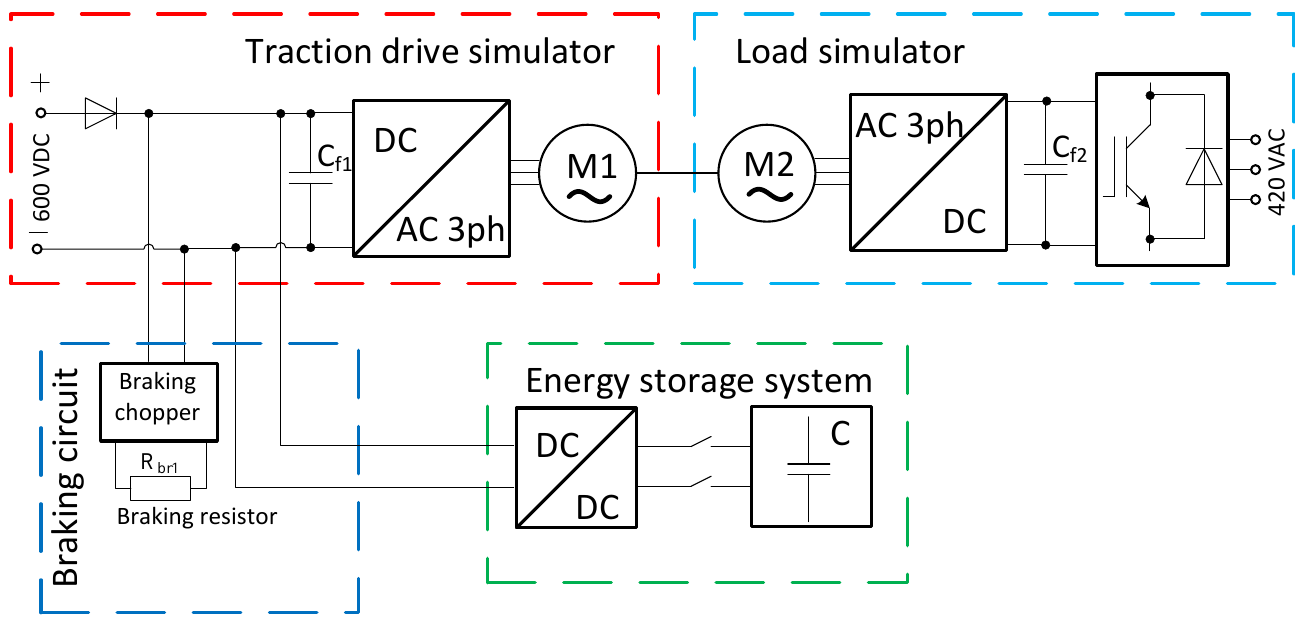
Fig. 1. Simplified diagram of the test bench. On the other hand, smaller capacitance stands for a smaller number of SCs and that is cheaper from the point of view of exploitation prices.